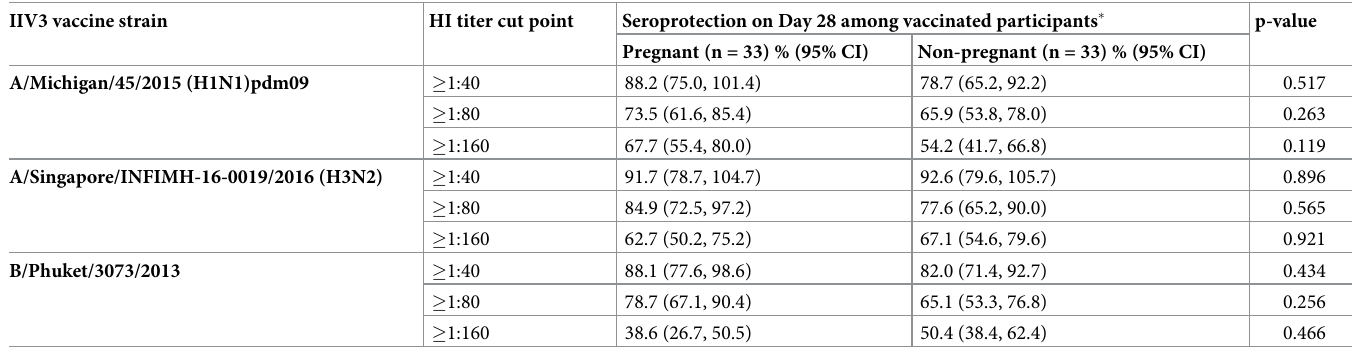
Table 3. Proportions of vaccinated participants reaching hemagglutination inhibition antibody titers of � 1:40, � 1:80, � 1:160 on one-month post vaccination. IIV3 vaccine